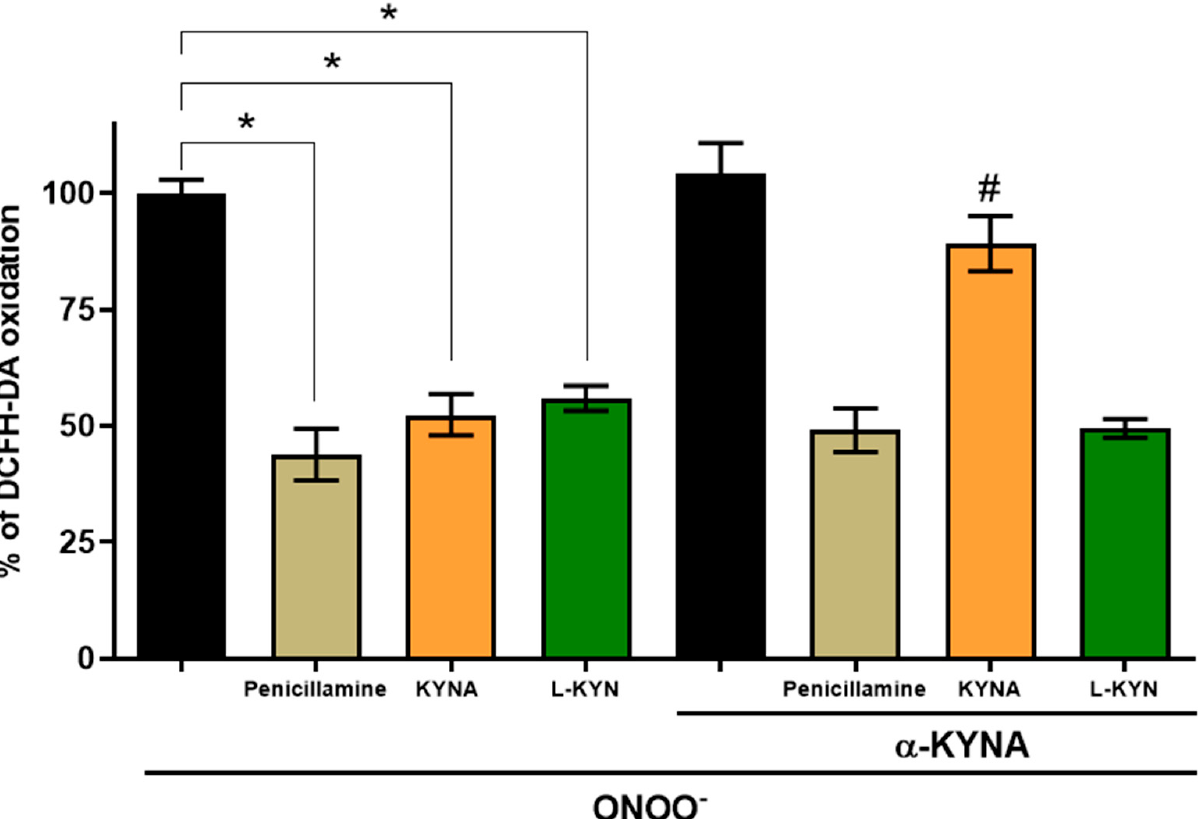
Figure 3. Effect of kynurenic acid (KYNA) antibody on the reduction of DCF-DA oxidation in the presence of ONOO − scavengers: Penicillamine, KYNA and L-KYN. Anti-KYNA antibody was used as a tool to exclude the involvement of KYNA in the ONOO − scavenging activity of L-KYN. The anti-KYNA antibody was added to the mixture reaction prior to penicillamine (300 µ M), KYNA (600 µ M) and L-KYN (2.2 µ M). Data are presented as mean values ± S.E.M. of 8 independent experiments. * p < 0.05 vs. ONOO − and # p < 0.05 vs. the corresponding scavenger without α -KYNA, based on the Kruskal–Wallis test with Dunn’s test for multiple pairwise comparisons. Table 1. Effect of α -KYNA antibody on the reduction of DCF-DA oxidation in the presence of ONOO − and its scavengers. Medians of the DCF-DA oxidation percentages and p -values associated with the effect of ONOO − scavengers vs. ONOO − , using Dunn’s test for multiple pairwise comparisons. ONOO − ONOO − + α -KYNA Penicillamine KYNA L-KYN Penicillamine KYNA